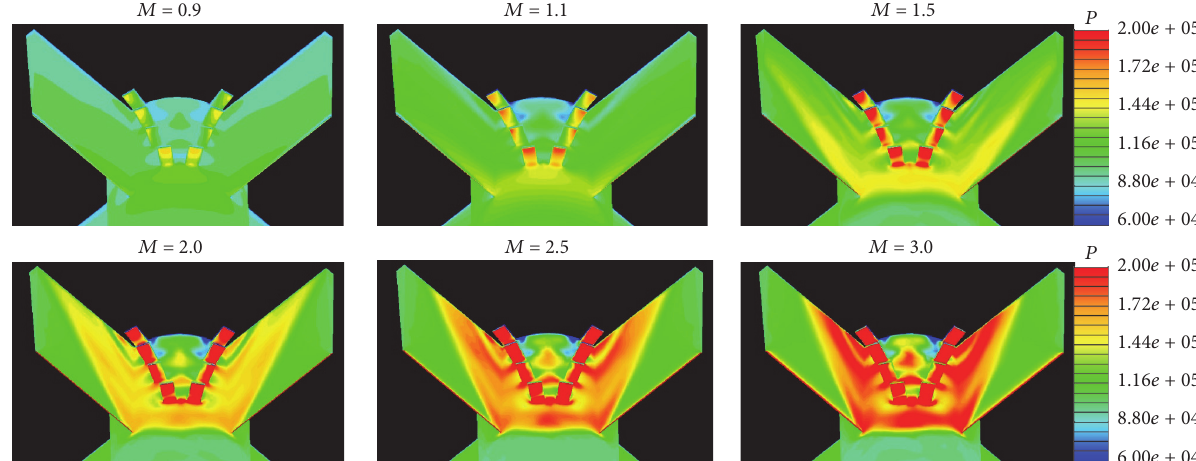
Figure 11: Computed surface pressure contours in the afterbody fin region near the microflaps for the 8-flap optimized configuration at various Mach numbers, 𝛼 = 0 ∘